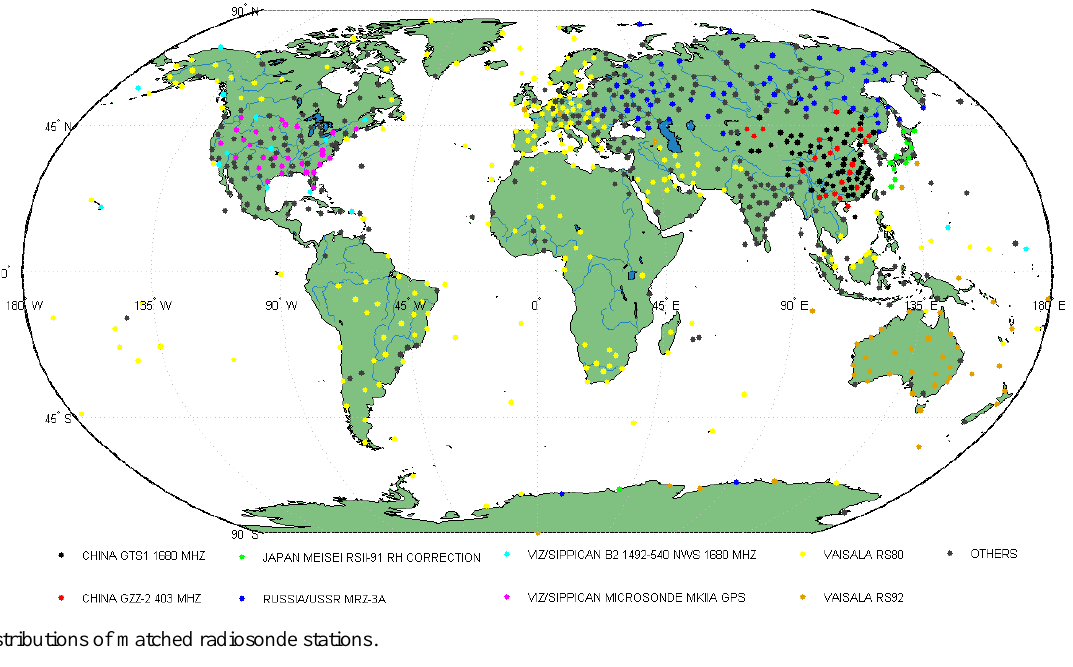
Fig. 1. Distributions of matched radiosonde